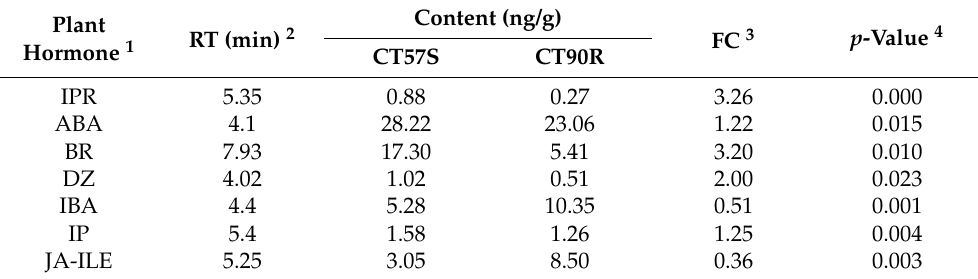
Table 1. Plant hormone identified in cucumber leaves in cold treatment.